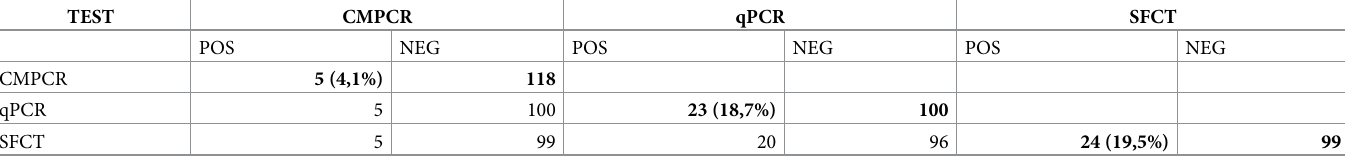
Table 1. Matrix of the results of the two faecal tests (CMPCR and qPCR) and the reference standard (SFCT) for the detection of Echinococcus multilocularis in 123 foxes.